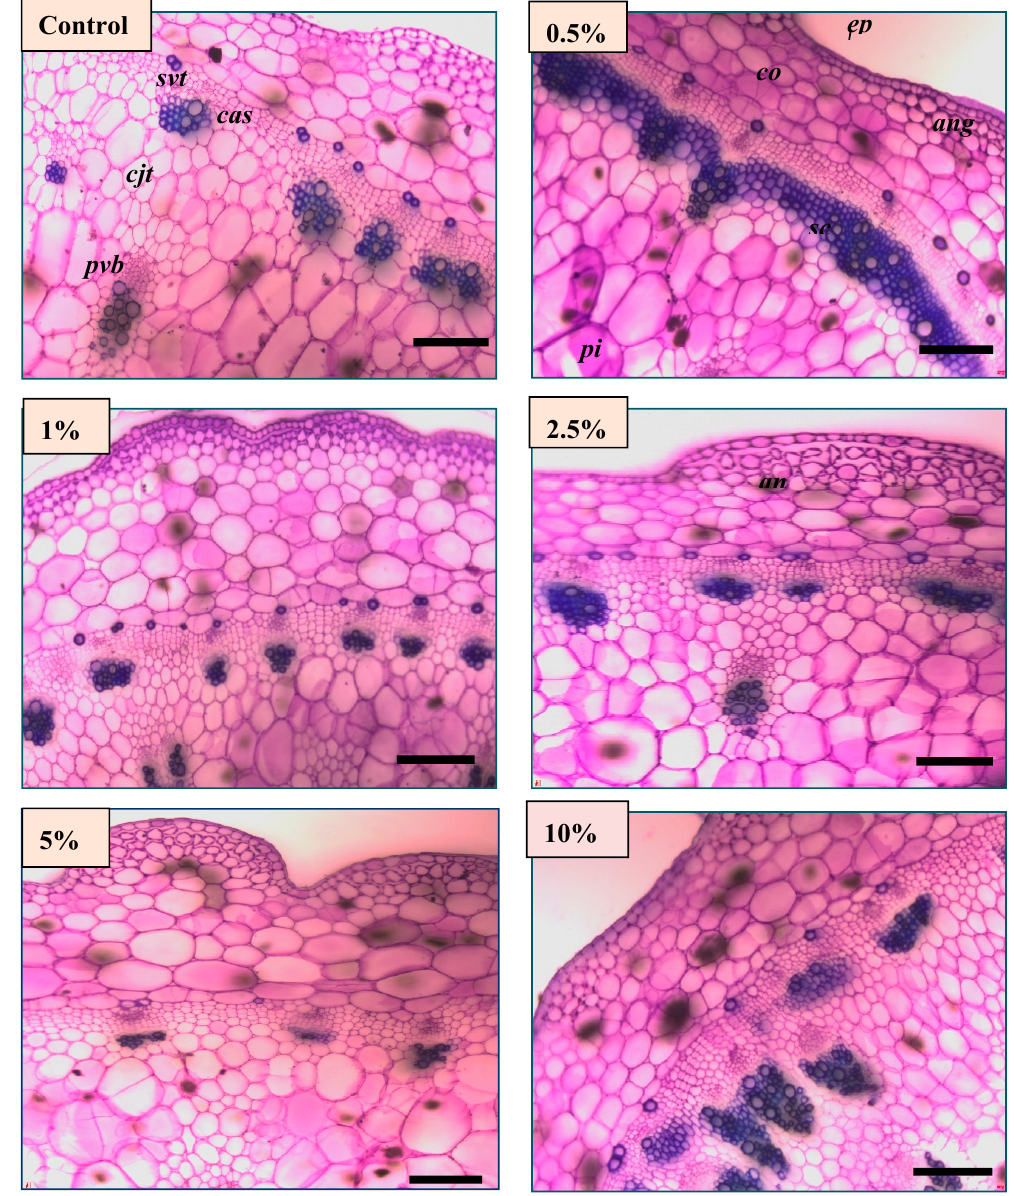
Figure 5. Anatomical sections of Celosia argentea var. plumosa stem. ep epidermis, co cortex, ang angular collenchyma, pi pith, sc successive cylinder ( svt secondary vascular tissue), ca cambium, cjt conjunctive tissue, pvb primary vascular bundle after spraying Celosia plants with di ff erent rates of fermented brown juice (i.e., control, 0.5%, 1%, 2.5%, 5%, and 10%). Scale bar is 200 µ